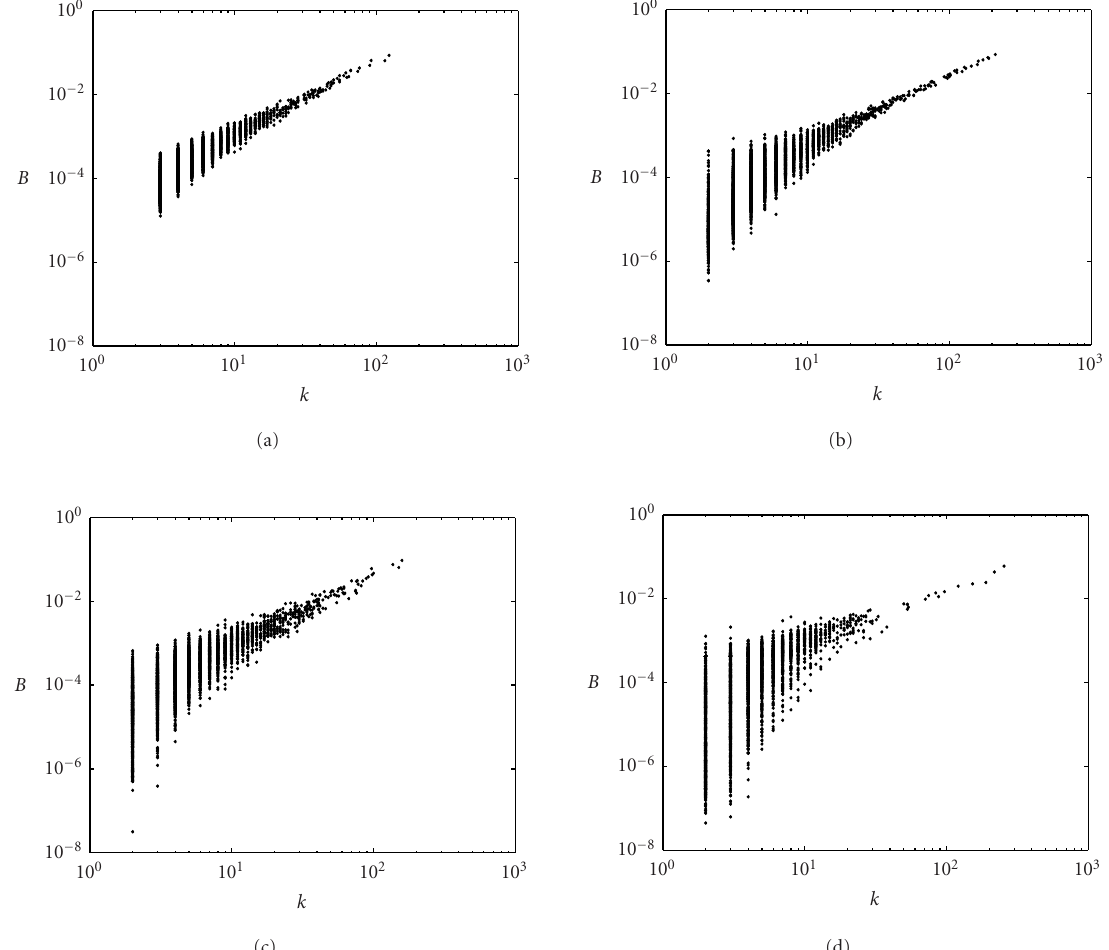
Figure 2. The k − B plot for various model generative algorithms. (a) Barabasi-Albert (BA); (b) extended BA (EBA); (c) Sole-Vazquez (SV); (d) duplication mutation